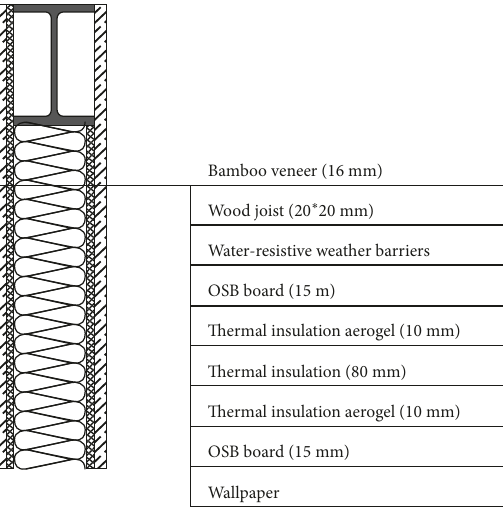
Figure 8: Construction design detail of an exterior wall using AB as the insulation material (source: authors’ own data).